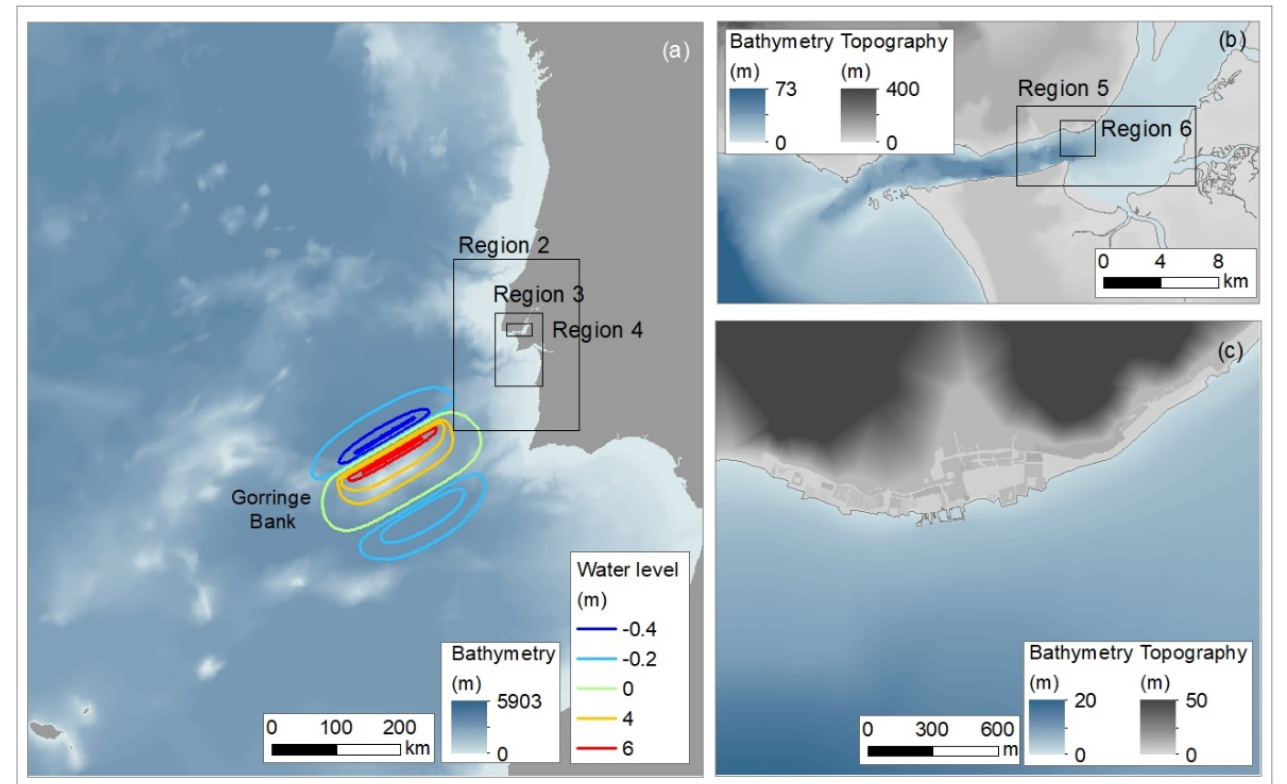
Figure 3. Conditions of the numerical model setting and bathymetry data: ( a ) Tsunami initial sea surface displacement on region 1, and placement of region 2, 3, and 4; ( b ) region 4 and the placement of regions 5 and 6; ( c ) details of region 6.